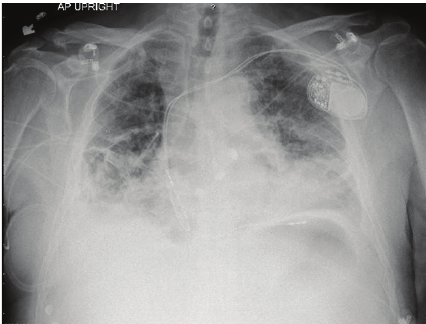
Figure 1: Chest X-ray on presentation showing bilateral lower lobe consolidations.